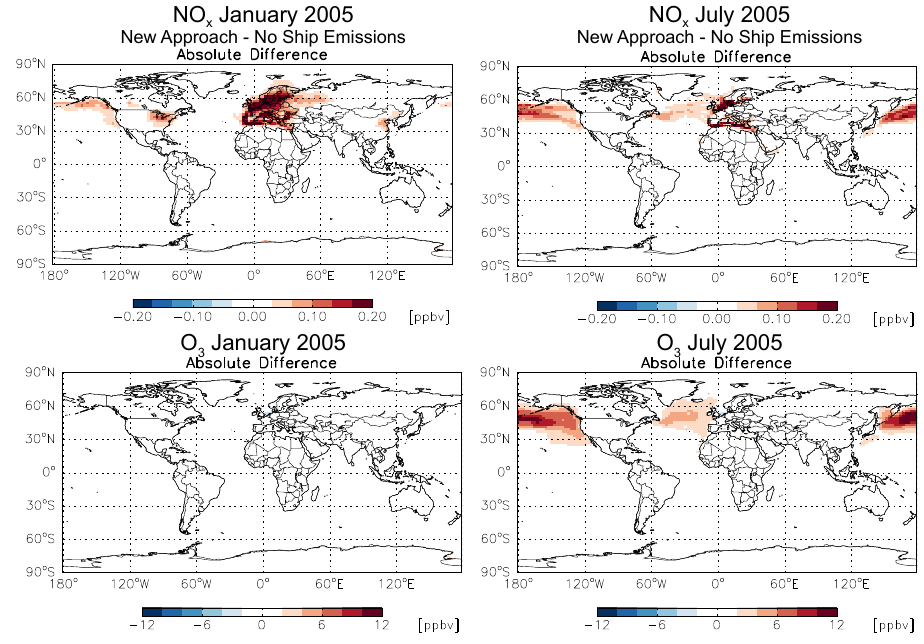
Fig. 10. Absolute difference plots between monthly mean global NO x and O 3 concentrations simulated with GEOS-Chem for January and July 2005 for the no ship emissions model and the new LUT approach model simulations, for the lowest model layer (0–0.12km).